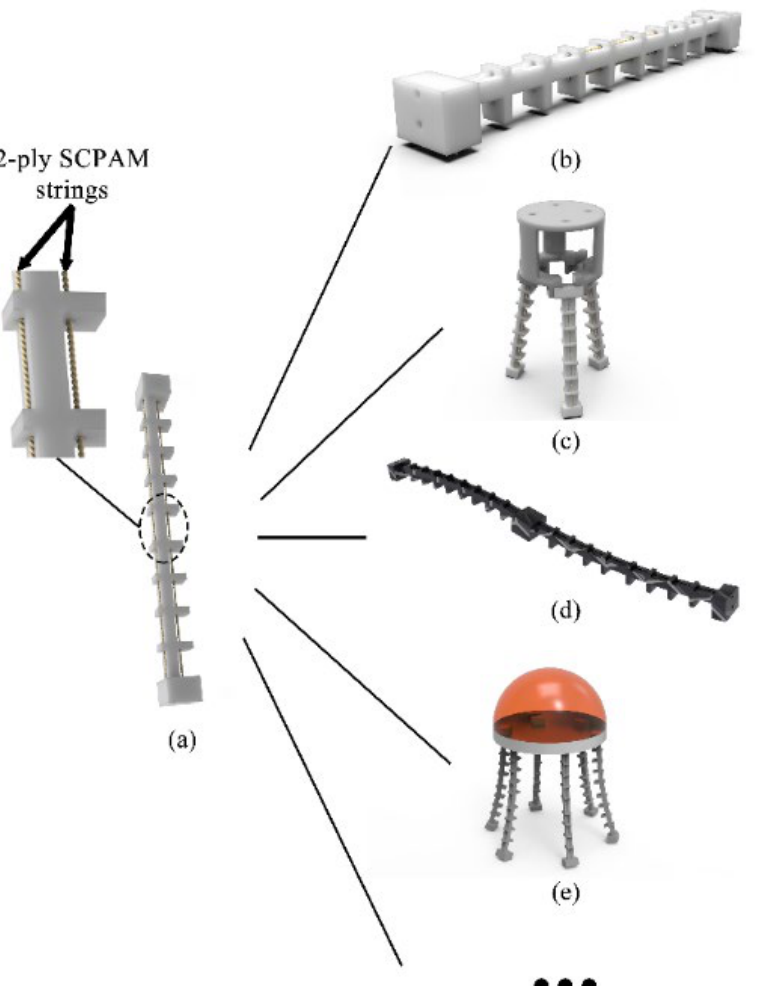
Figure 1. A single soft robot module and soft robots configured by the modules. ( a ) A single soft robot module, and chambers to configure the actuator and sensor. ( b ) An inchworm-inspired crawling robot. ( c ) A soft robotic gripper. ( d ) A snake-like manipulator. ( e ) A jellyfish-inspired robot with underwater swimming capability.